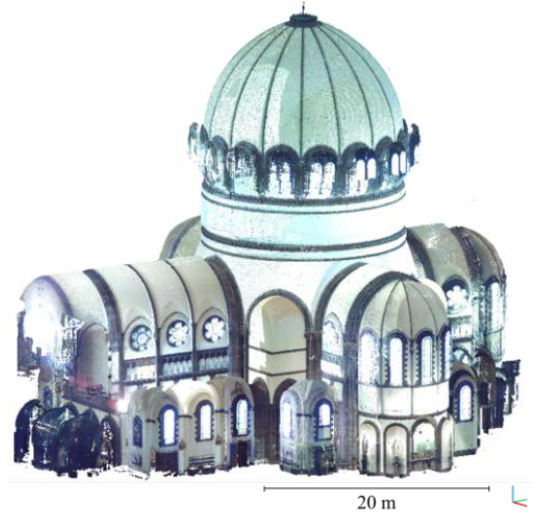
Figure 5. Overview of the colorized registered dataset (interior part of the